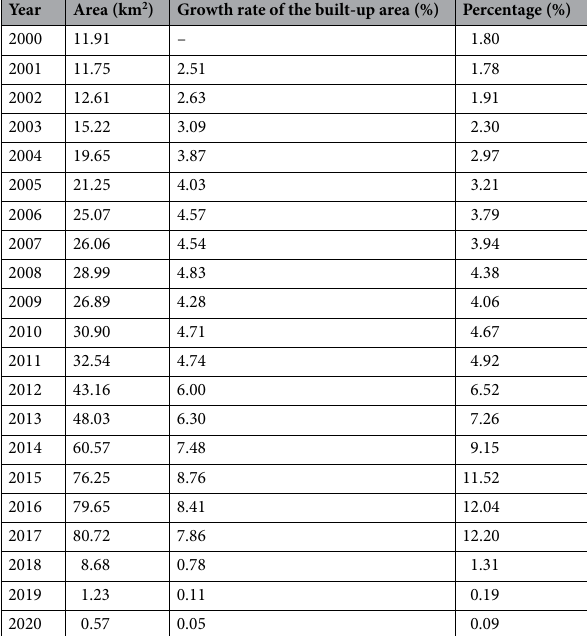
Table 1. Interannual variation area, growth rate, and proportion of urban built-up area in Karachi.